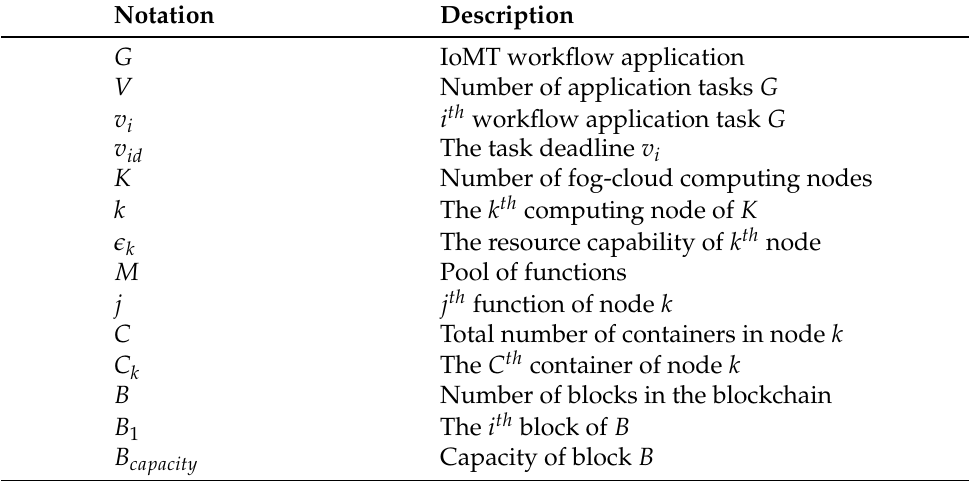
Table 2. Mathematical